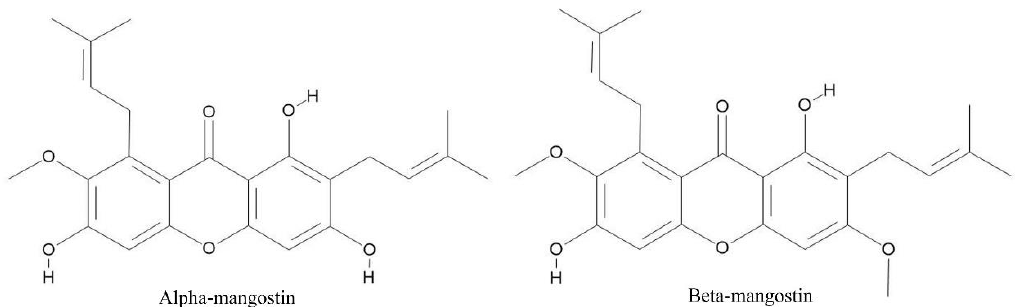
Figure 1. The two-dimensional structure of α -MG and β -MG drawn in the MedChem Designer ™ program. Table 1. The predictive likelihood of α -mangostin ( α -MG) and β -mangostin ( β -MG) to interact with Pgp via the ADMET Predictor ™ program.